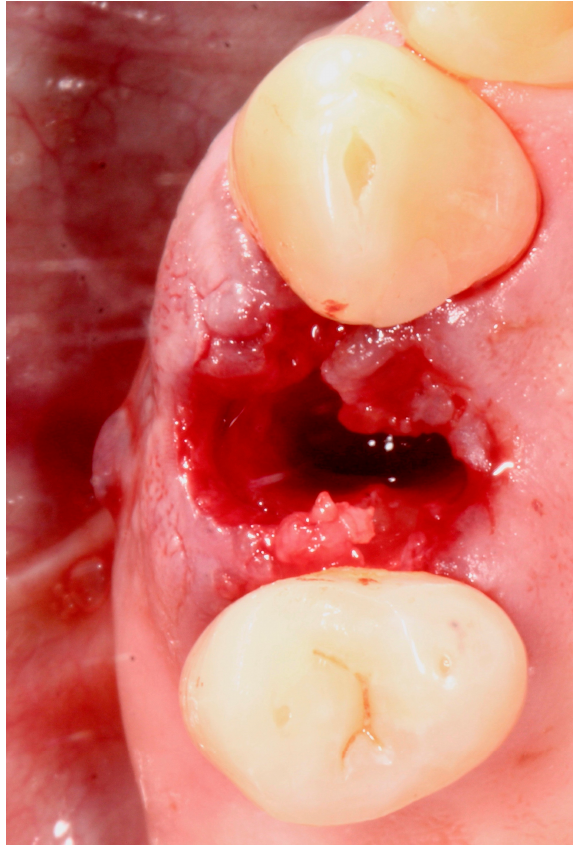
Figure 2. Alveolar cavity after atraumatic flapless extraction.